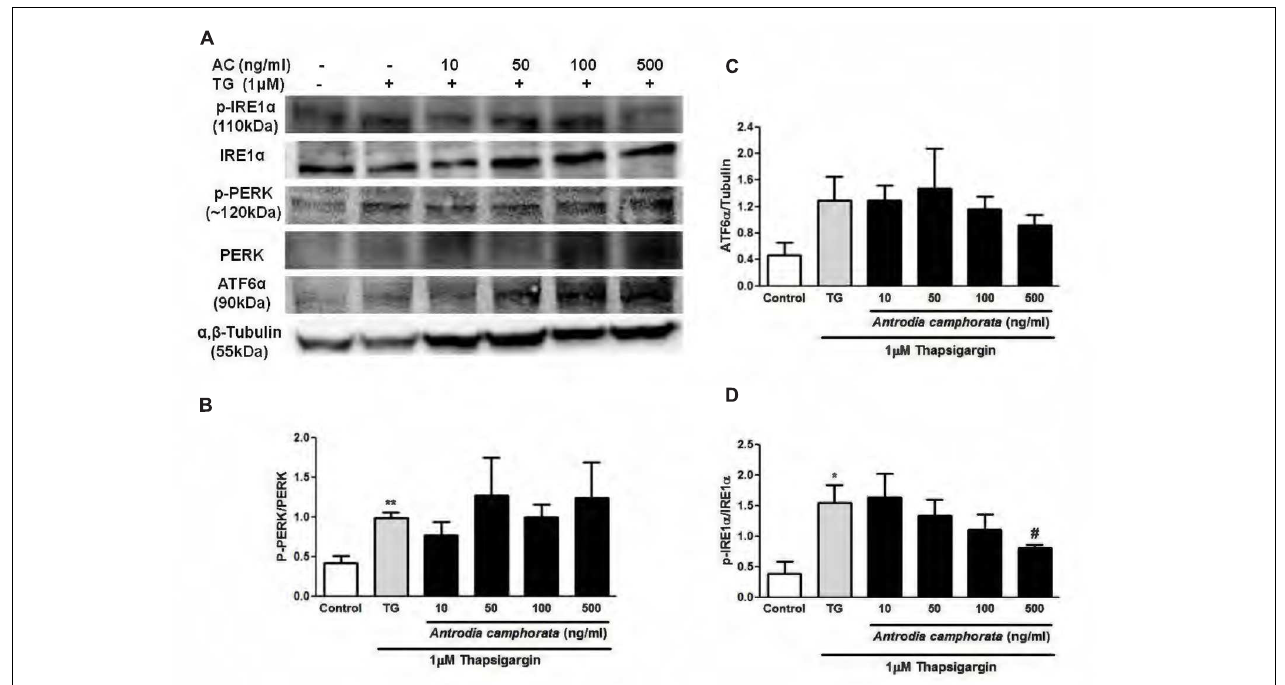
FIGURE 5 | Antrodia camphorata reduced ER stress-induced apoptosis by downregulating IRE1 α pathway in MIN6 cells. The cells were treated with A. camphorata (AC; 10–500 ng/ml) for 24 h and then stimulated with 1 µ M TG for 6 h. (A) Immunoblots showing the protein expressions of phospho-IRE1 α , IRE1 α , phospho-PERK, PERK, and ATF6 α . (B) Representative graphs showing the protein expressions of phospho-PERK/PERK, n = 4. ∗∗ P < 0.01 vs. control. (C) Representative graphs showing the protein expressions of ATF6 α , n = 5. (D) Representative graphs showing the protein expressions of phospho-IRE1 α /IRE1 α , n = 4. ∗ P < 0.05 vs. control; # P < 0.05 vs. TG. Results were expressed as mean ±